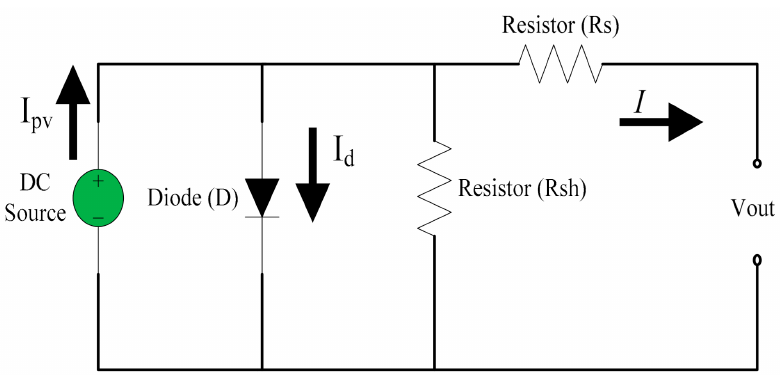
Figure 1. Equivalent circuit of single diode